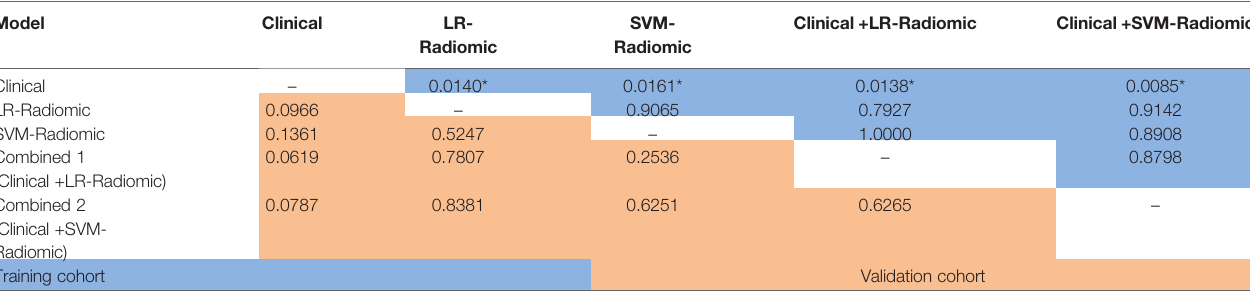
TABLE 14 | Delong Test between each two models (clinical, radiomic, clinical features + radiomic model) in the training and validation